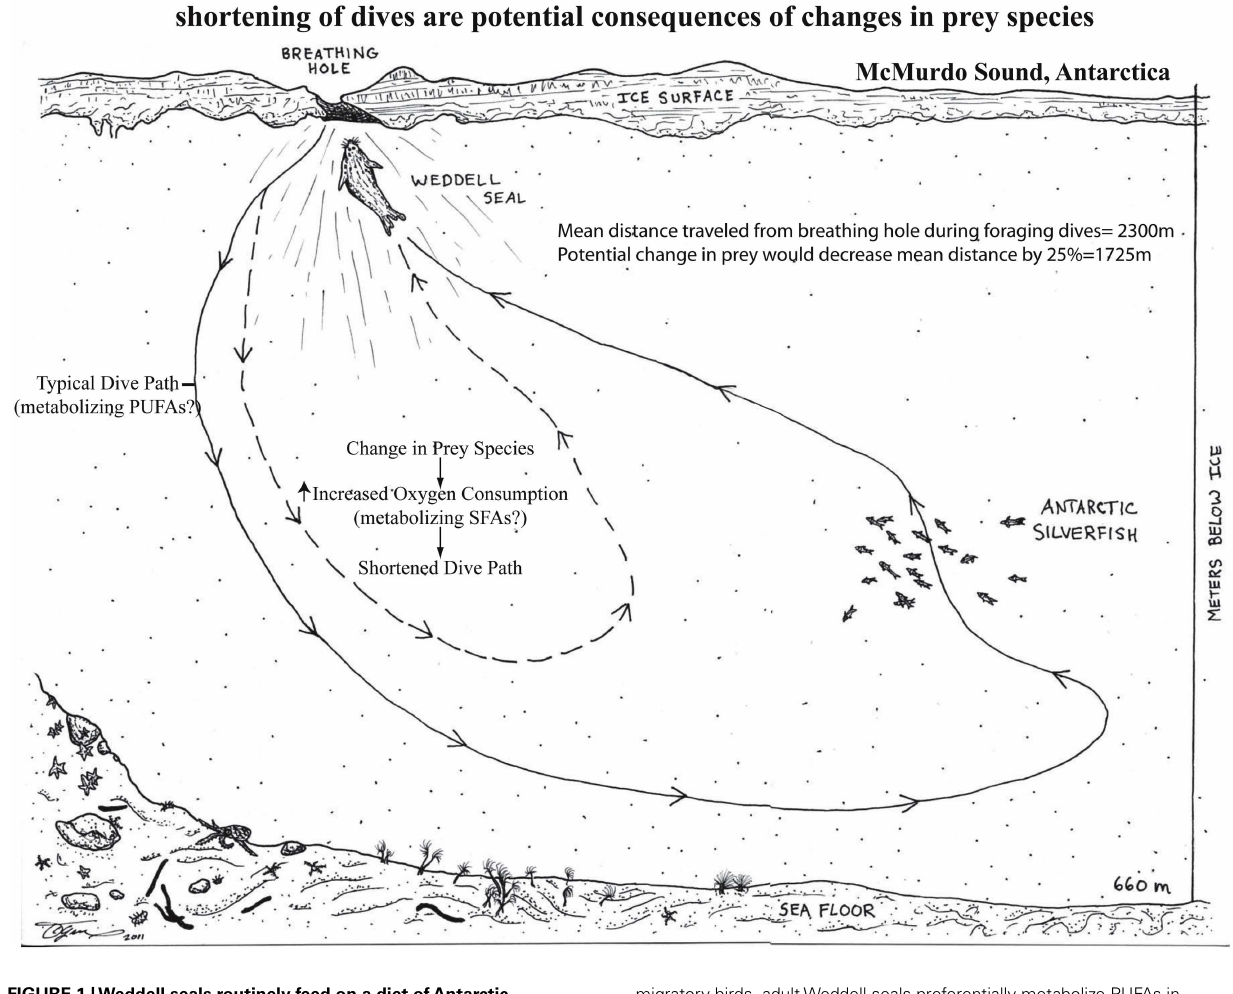
migratory birds, adultWeddell seals preferentially metabolize PUFAs in contrast to either monounsaturated or saturated fatty acids (Trumble et al.,